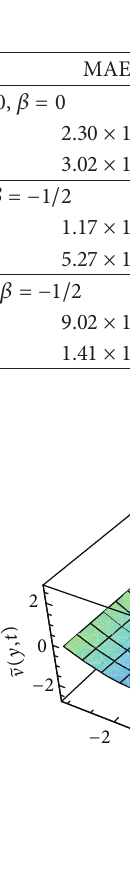
Figure 13: The approximate solution ̃𝑢 of problem (55), where 𝑁 = 10 and 𝛼 = 𝛽 = 1/2 in the interval [0,1] .